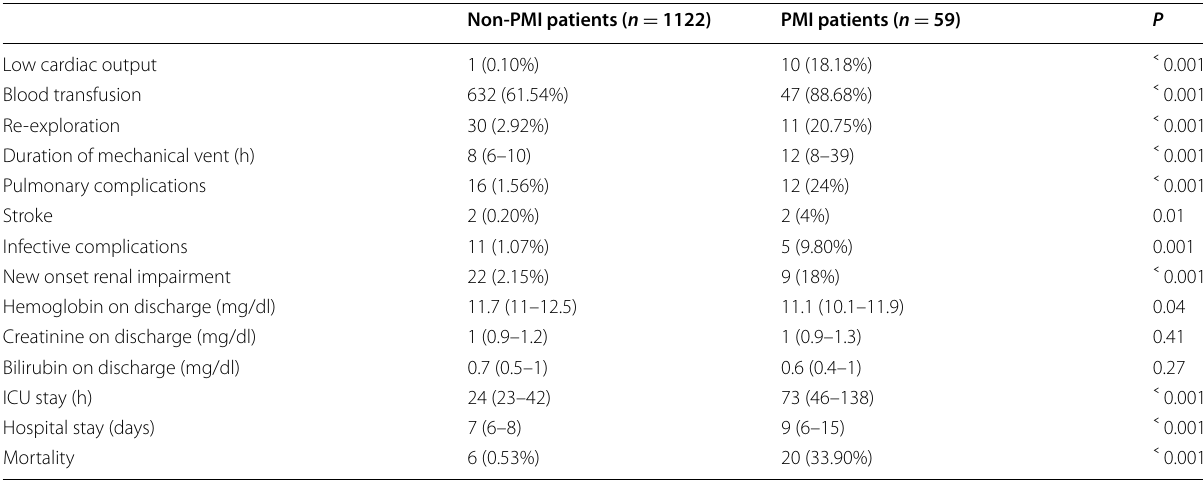
Table 3 Comparison of the postoperative outcomes between patients with and without perioperative myocardial infarction